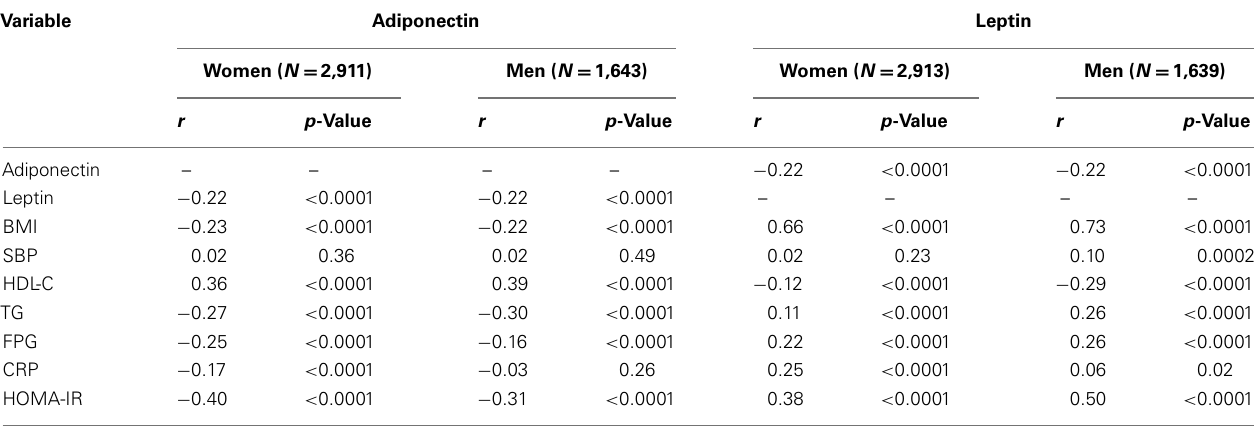
Table 2 |Age-adjusted partial correlations of log-adiponectin and log-leptin to individual cardiovascular risk factors/study covariates. Variable Adiponectin